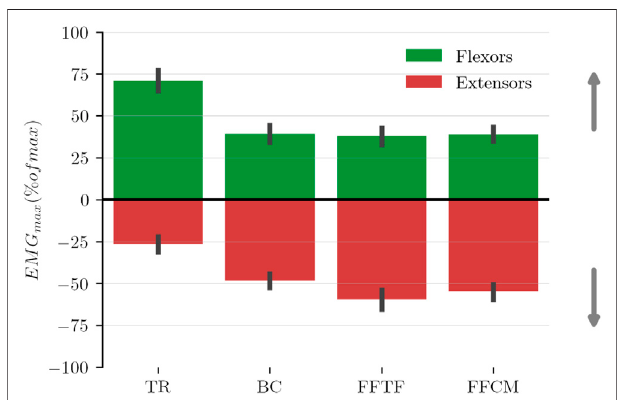
FIGURE 11 | Mean normalized peak of muscular activity of the agonist muscles estimated during the movement acceleration phase. Flexors are agonist for upward movements (depicted with positive values) and extensors are agonist for downward movements (depicted with negative